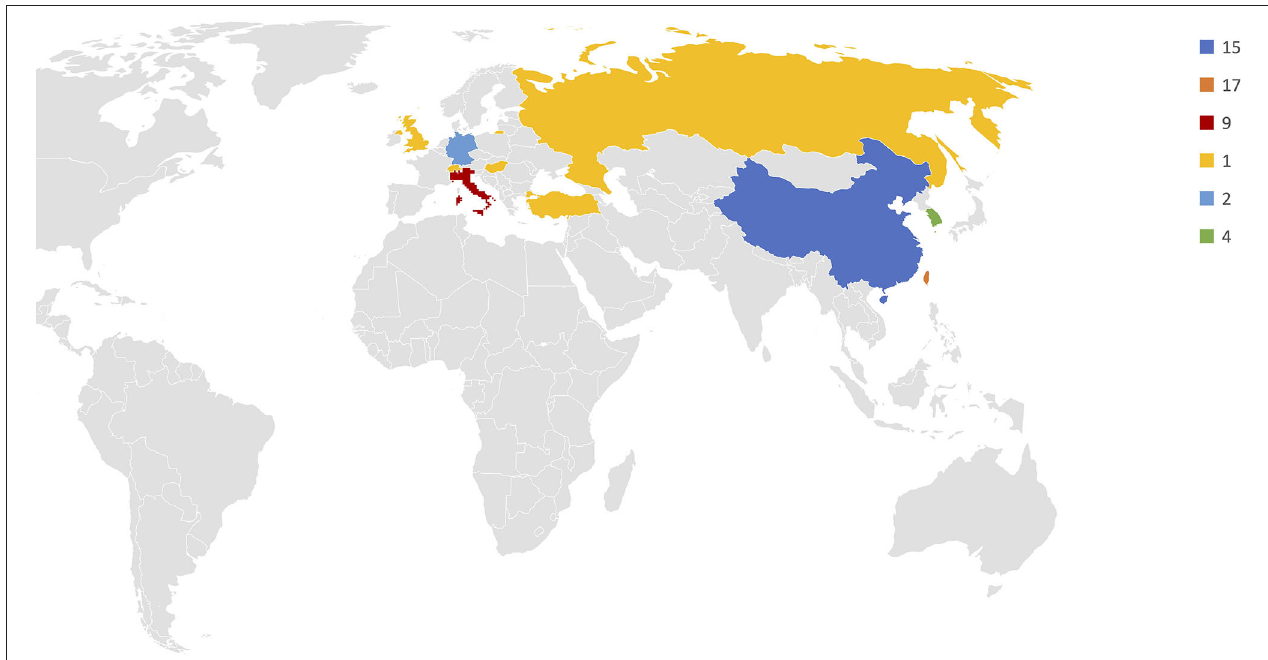
FIGURE 1 | Frequency distribution of studies conducted on